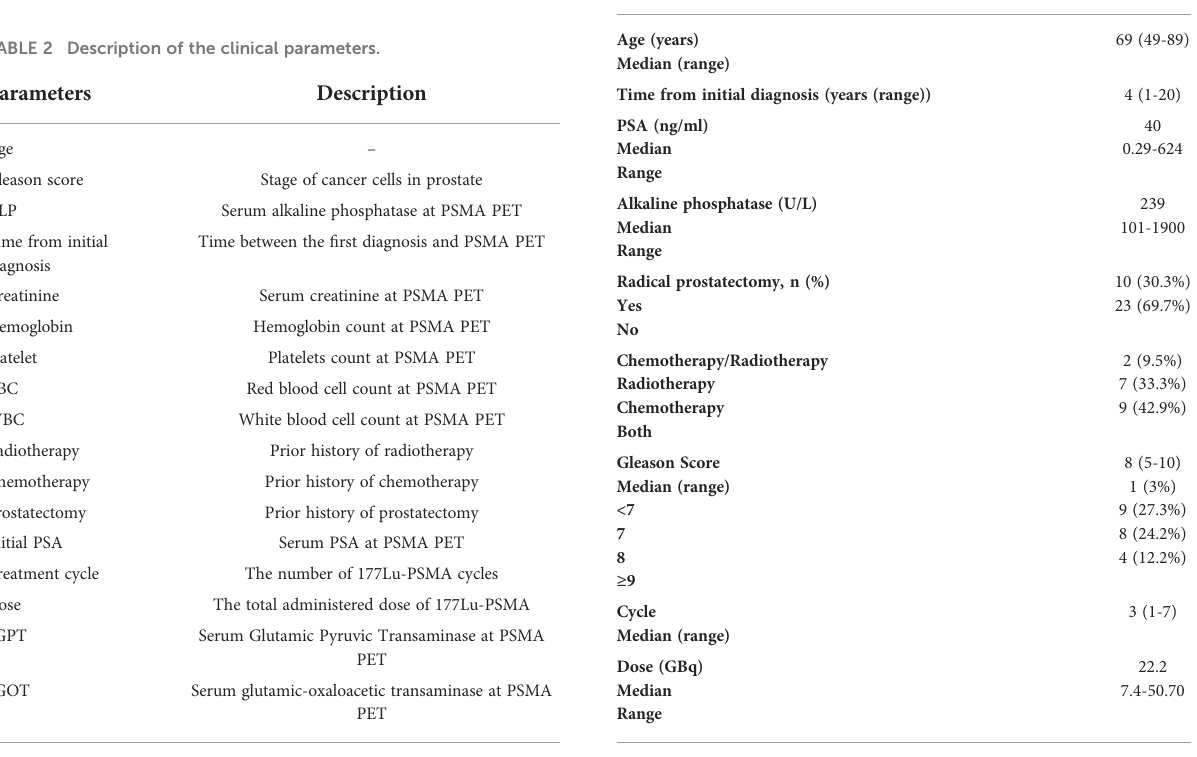
TABLE 3 Patients ’ characteristics.